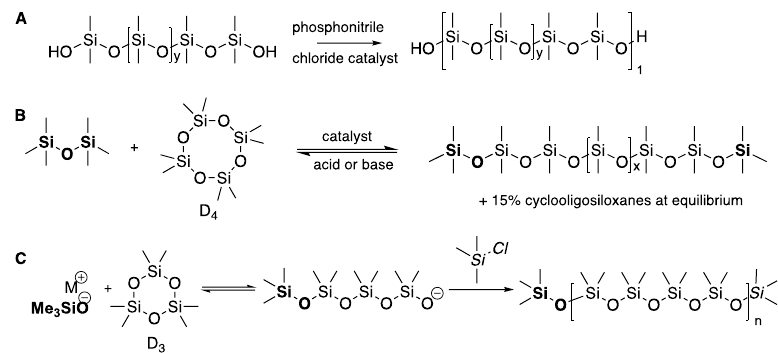
Figure 1. Traditional routes to silicone polymers: ( A ) silanol condensation; ( B ) redistribution; ( C ) ring-opening polymerization.